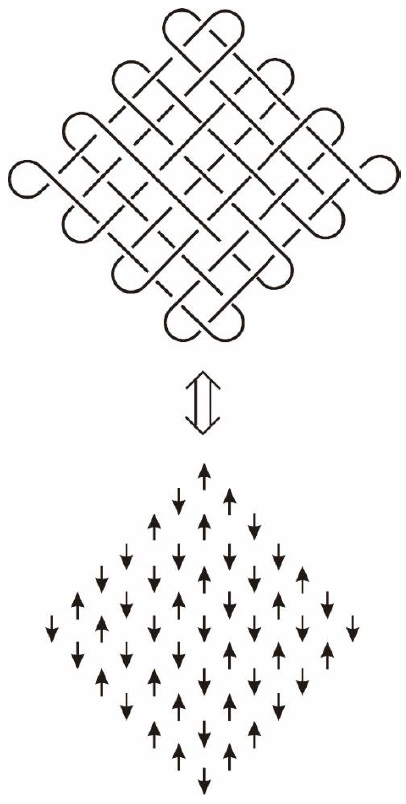
Figure 2. Mapping between the 2D-knot diagram with randomly distributed crossings on a lattice M [20] and a spin dual lattice L .